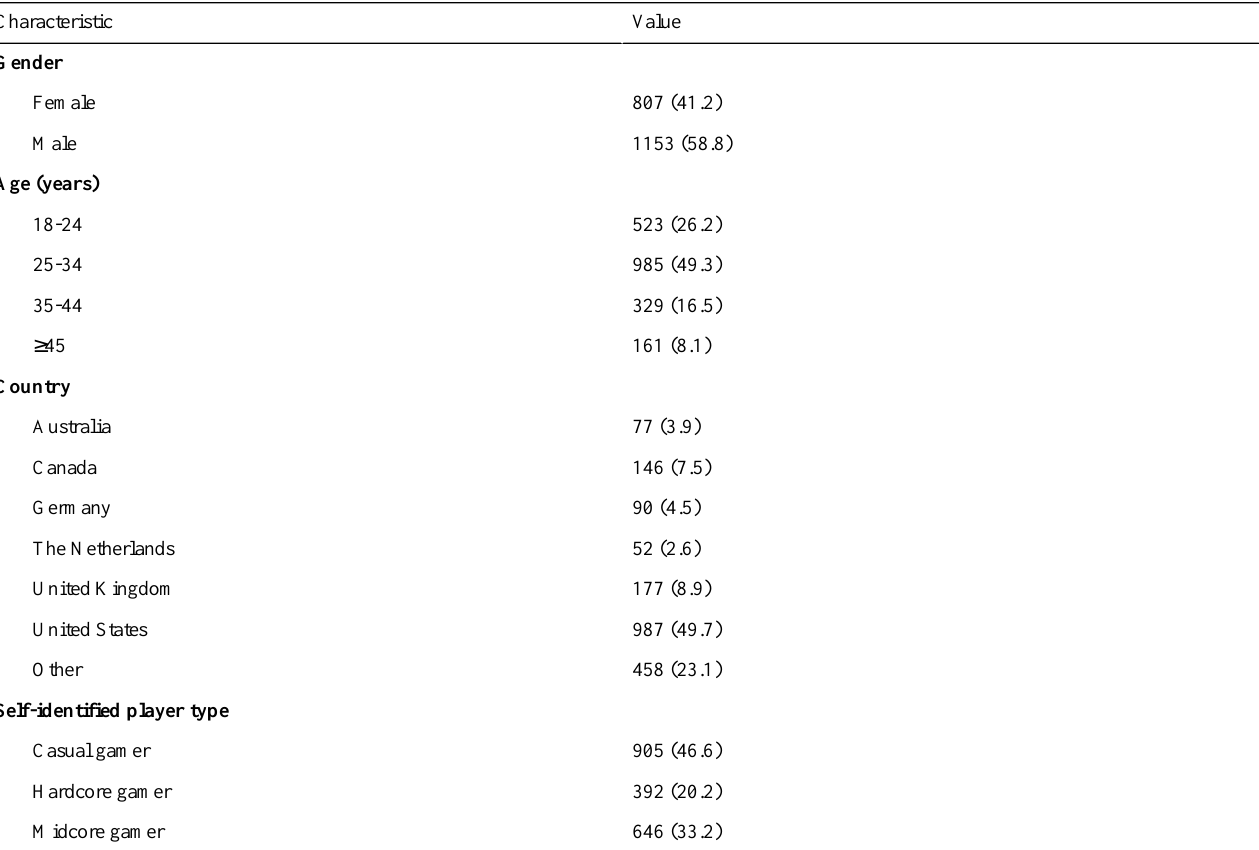
Table 1. Demographic characteristics of survey respondents (N=2004), n (%). Values may not equal total N due to missing demographic